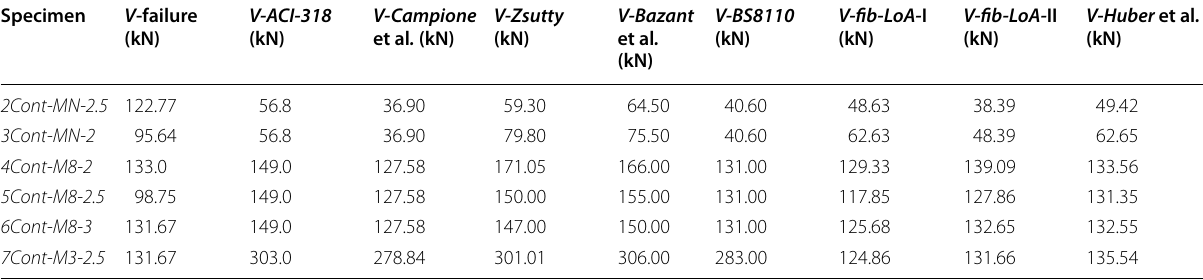
Table 7 Shear strength